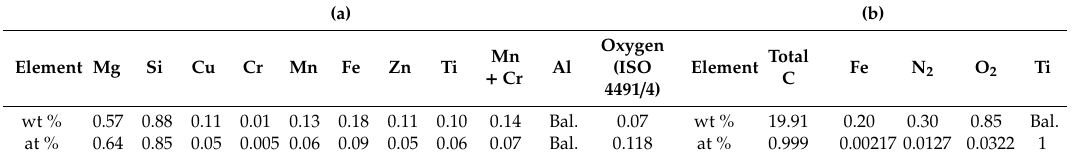
Table 1. ( a ) Chemical composition of the Al–Mg–Si–(Cu) 6005A alloy powders in the as-received